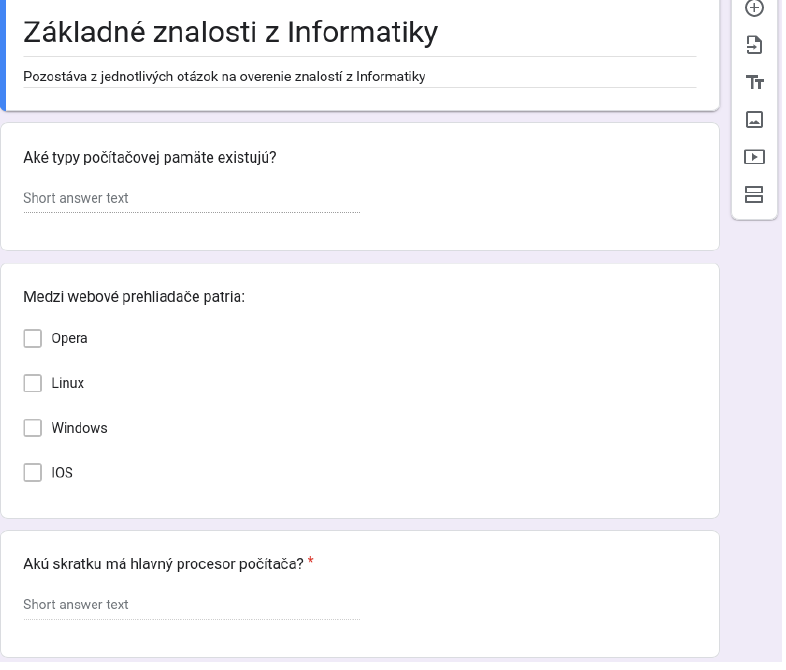
Figure 2. Example quiz in the Google Forms